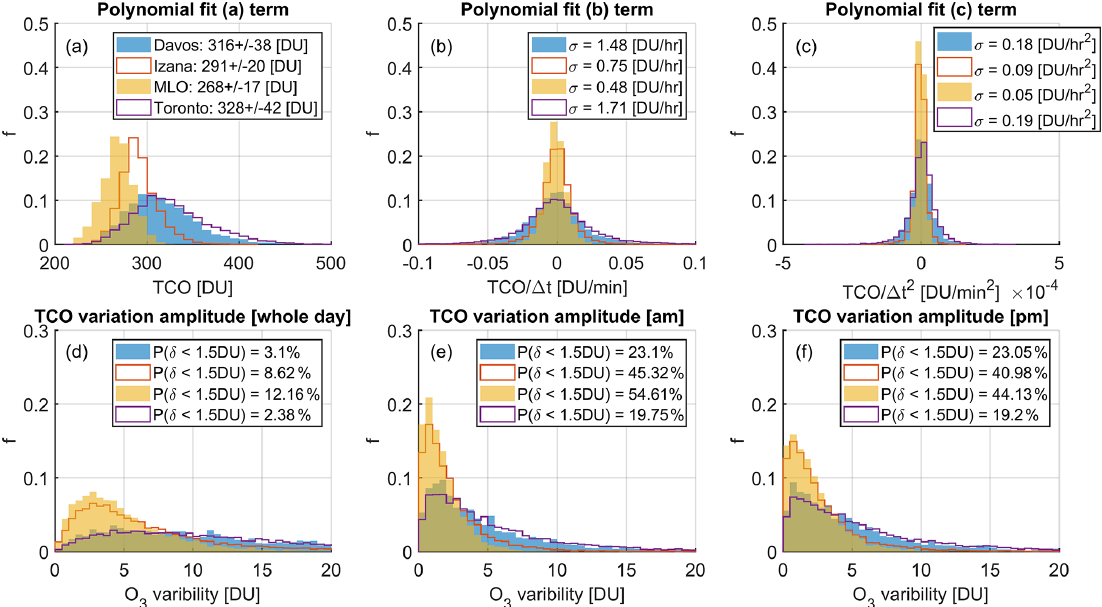
Figure 3. Short-term ozone variability for Davos, Izaña, MLO, and Toronto sites, as derived from MERRA-2 data. The distribution of the three simple second-order polynomial fitting parameters is shown in panels (a–c) . The distributions of TCO variation amplitudes are shown in panels (d–f) , with the probability of TCO variation amplitude less than 1.5DU indicated in the legends.